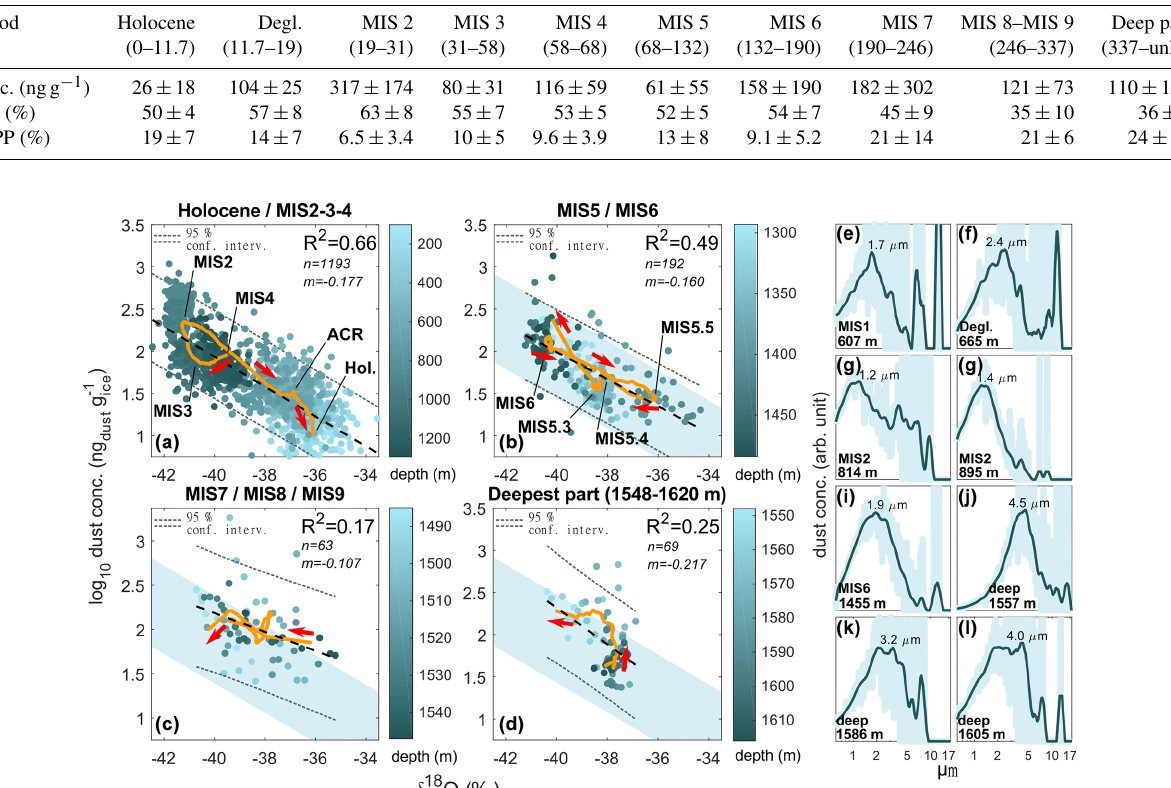
Table 1. Dust concentration in TALDICE. For each climatic period mean concentrations are reported along with standard deviations.